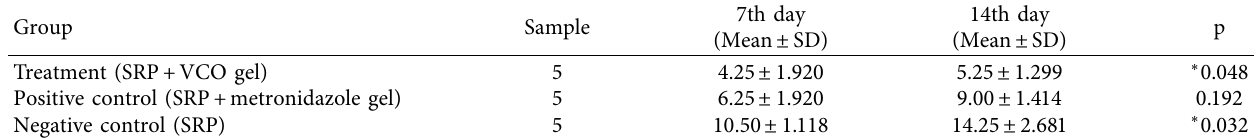
Table 1: Mean of TNF- α expression on the 7th and 14th day in each treatment group.